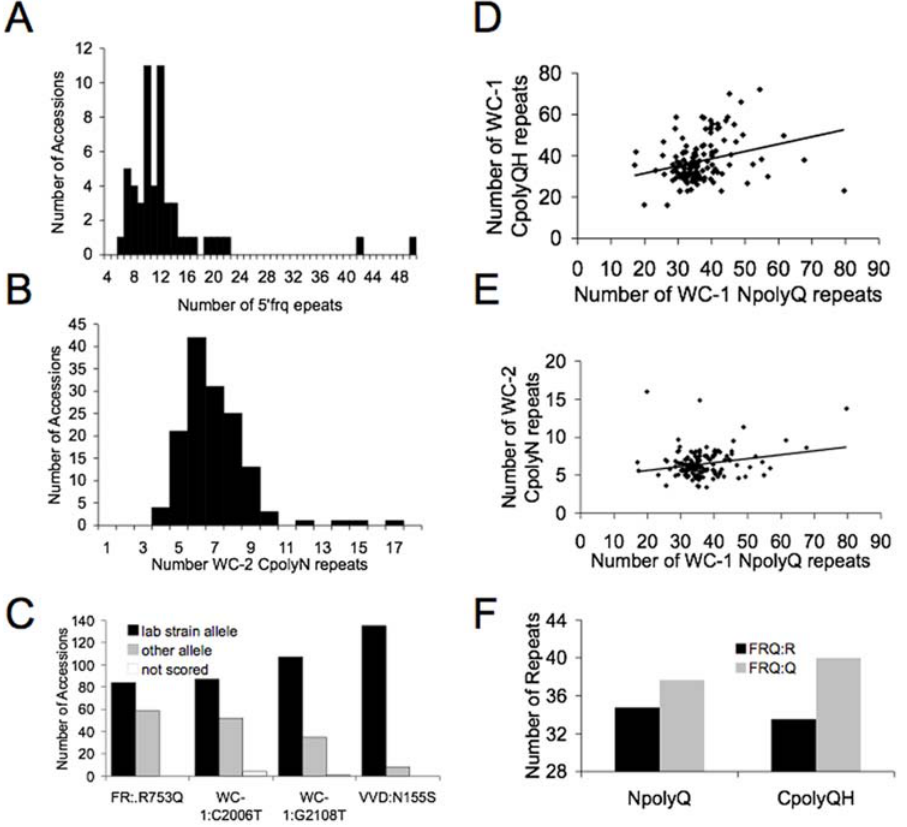
Figure 4. Genotypic variation WC-1, WC-2, FRQ and VVD. The number of 5 9 frq (A) and WC-2 CpolyN (B) repeats were estimated in the N. crassa accessions. (C) wc-1 , frq and vvd SNPs were scored across 143 accessions. The allele frequency of the reference strain (black) is shown in comparison to the other allele (grey) across the accessions. (D–E) Associations between repeat length of NpolyQ and CpolyQH (D), and WC-2 CpolyN and NpolyQ (E). (F) The average length of both the NpolyQ and CpolyQH were significantly different by a student’s t-test when grouped for the presence of the FRQ: R753 or FRQ: Q753 allele (p , 0.05). All data is available in Table S1.